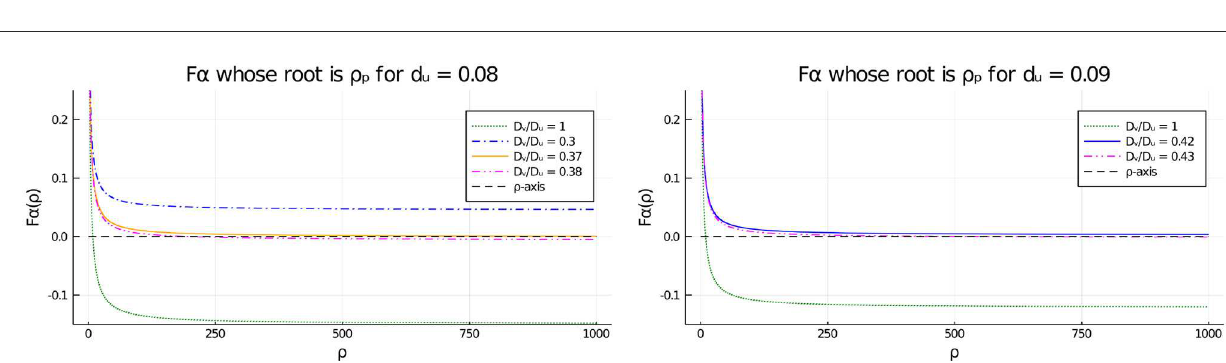
FIGURE10 Effect of the diffusivity ratio D v / D u of the two bulk species on the extent of the hysteresis when d u bifurcation points and the subcritical pitchfork bifurcation point (Left) and by the distance of the two asymmetric equilibria µ e 1 and µ e 2 from each other (Right) . The diffusivity D u 5 is fixed and the remaining parameters are as in Table 2. The dots are the numerically computed values using MatCont [51] = that are interpolated by the plotting function in Julia [53].